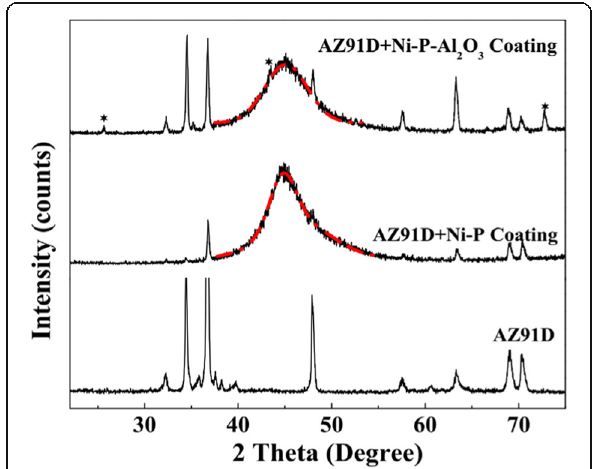
Fig. 3 XRD patterns of the AZ91D substrate, Ni-P coating, and Ni-P- Al